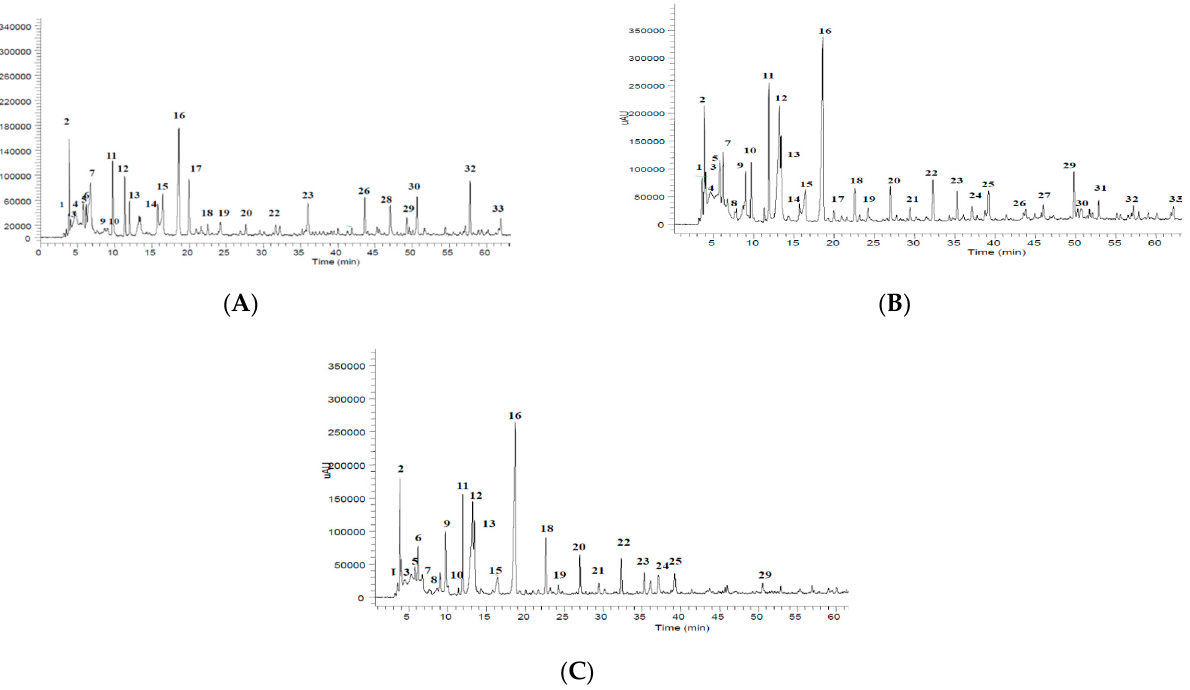
Figure 1. Identification of C. moschata polyphenols in ( A ) young, ( B ) mature, and ( C ) ripened fruits.